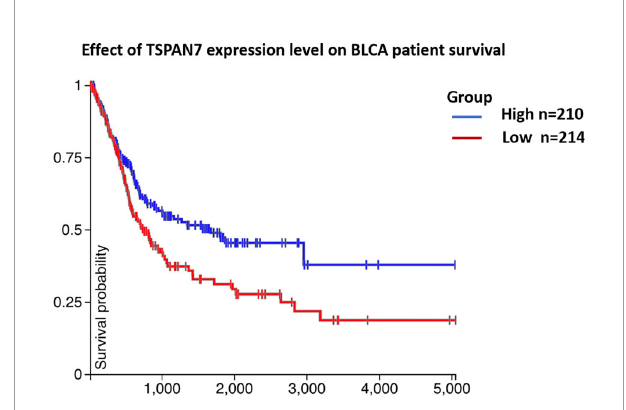
FIGURE 3 | ( Table 1 ) Association between TSPAN7 expression and clinicopathological features of human bladder cancer. ( Figure 3 ) TSPAN7 expression was signi fi cantly associated with poor overall survival from